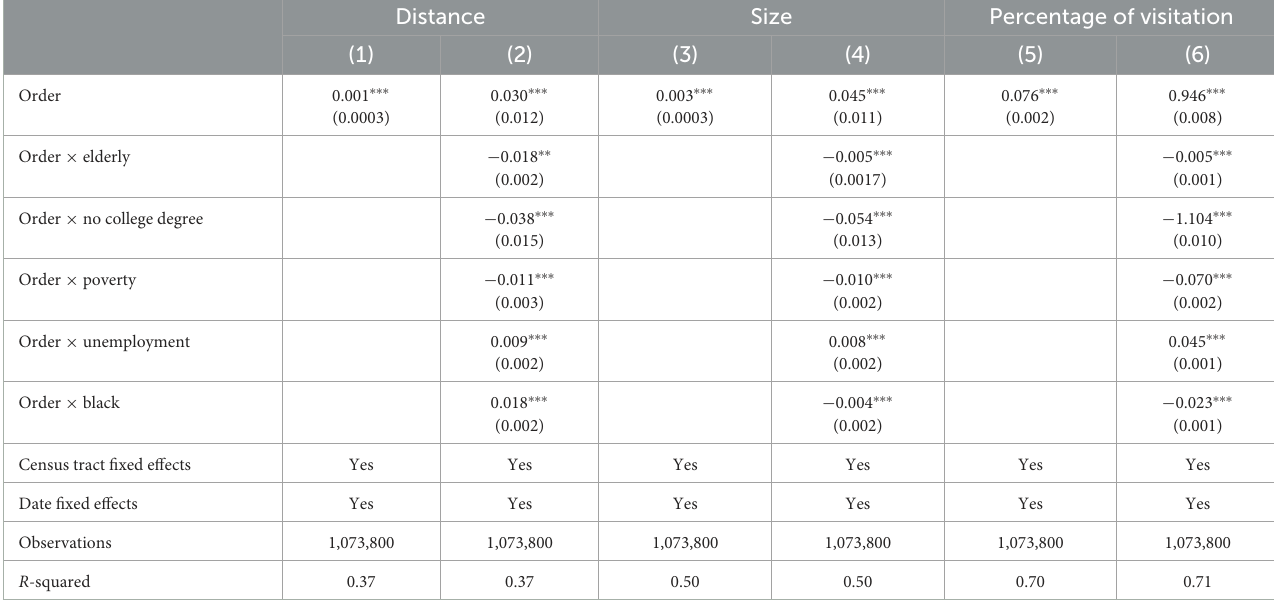
TABLE 2 Before and after stay-at-home order.